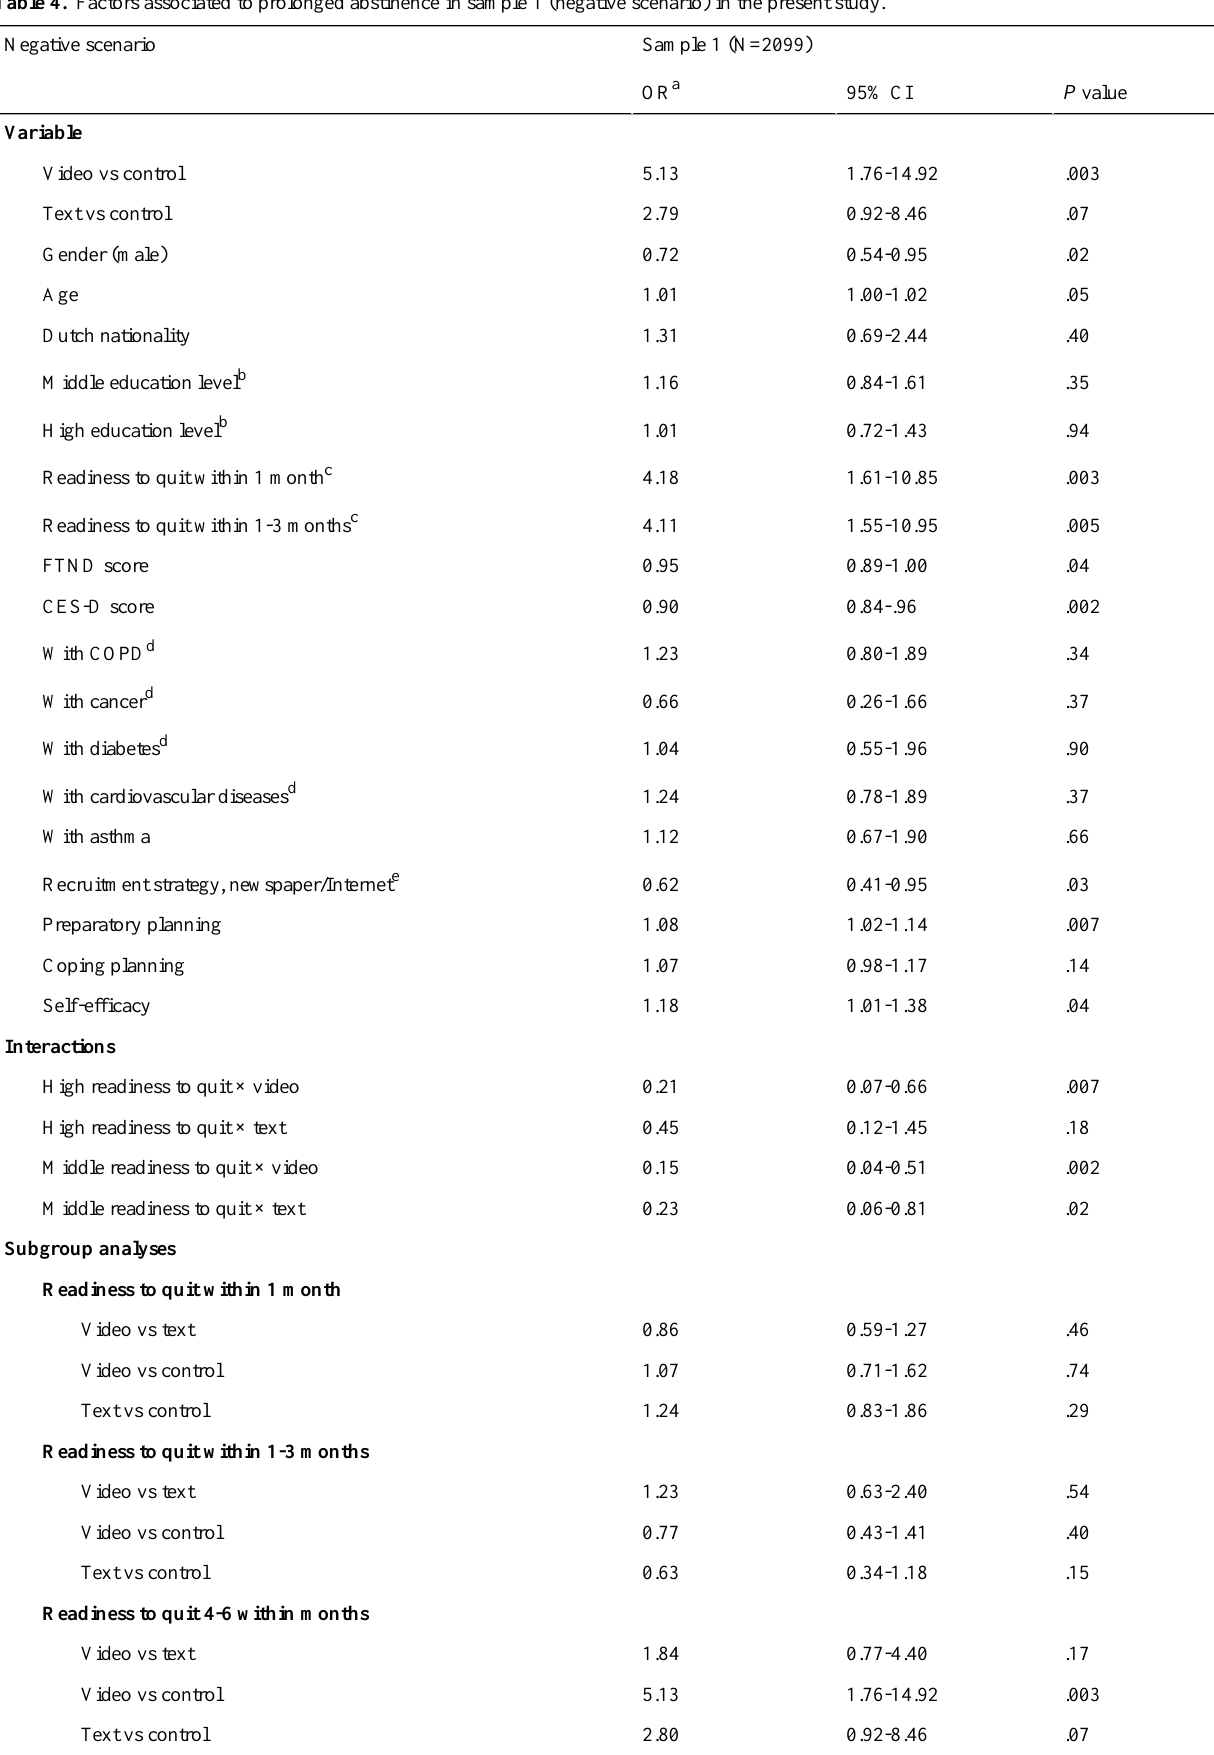
Table 4. Factors associated to prolonged abstinence in sample 1 (negative scenario) in the present